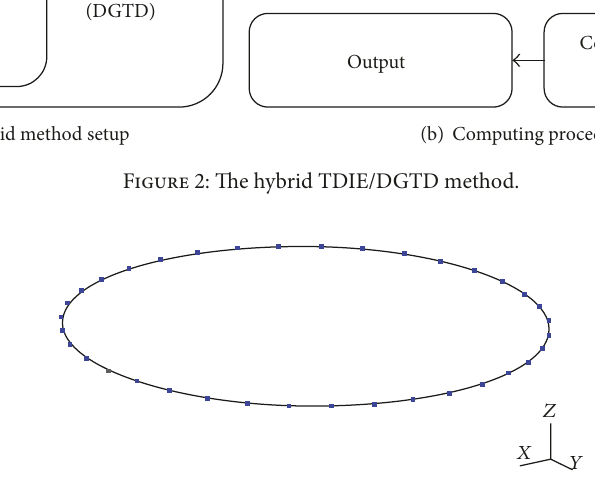
Figure 3: Circular antenna (divided into 35 straight